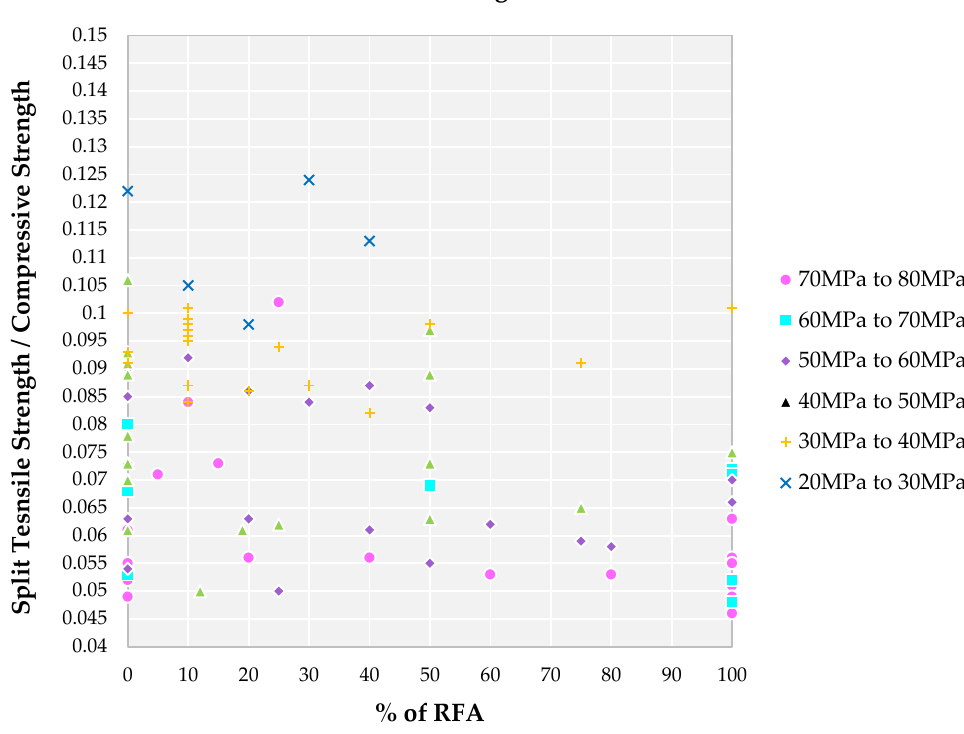
Figure 10. Impact of percentage of RFA on split tensile strength to compressive strength for different grades of SCC concrete with recycled aggregate according to literature.